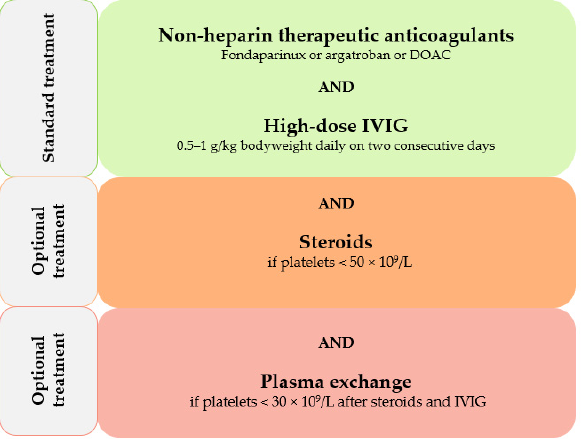
Figure 2. Therapeutic recommendations for vaccine-induced thrombotic thrombocytopenia (modified from ISTH [63]). Later on, by July 2021, the WHO issued comprehensive guidance on the diagnosis and management of VITT following COVID-19 vaccination. This guidance clearly recom- mends ELISA as the preferable method for the detection of antibodies against PF4 in pa- tients with suspected VITT, as rapid immunoassays are not that sensitive. In addition, the